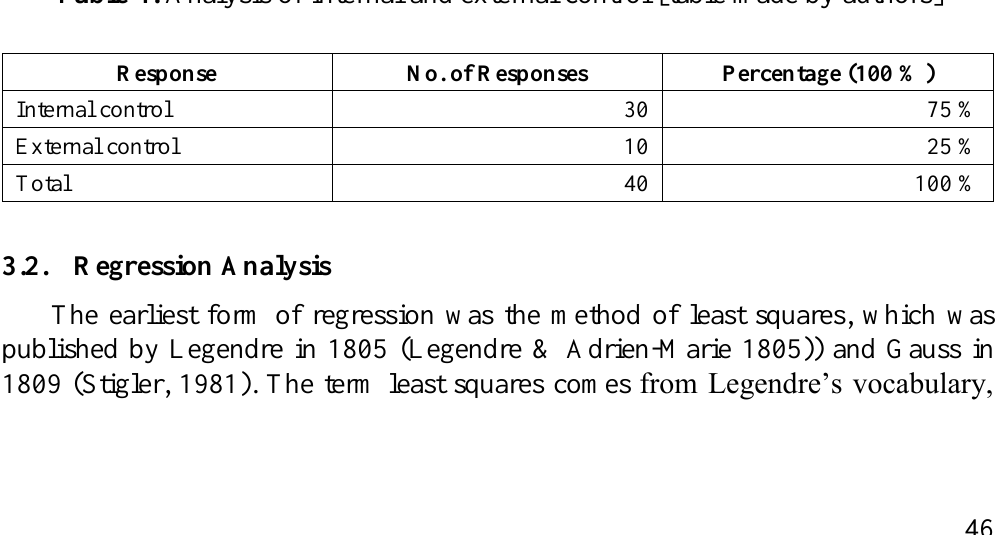
Table 4. Analysis of internal and external control [table made by